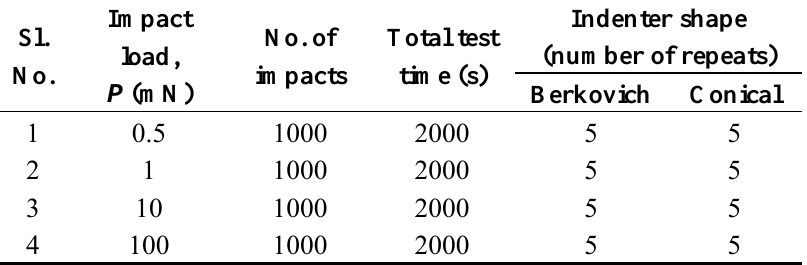
No. of Total test impacts time (s)